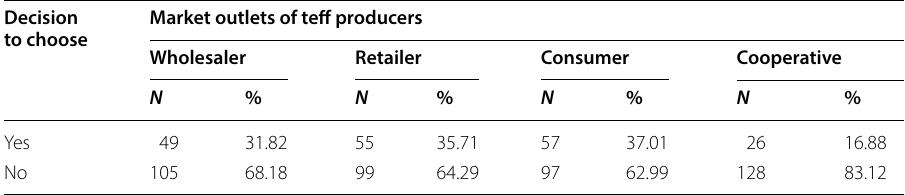
Table 2 Proportion of market outlets choosed by sample teff producers. Source: Survey data result,